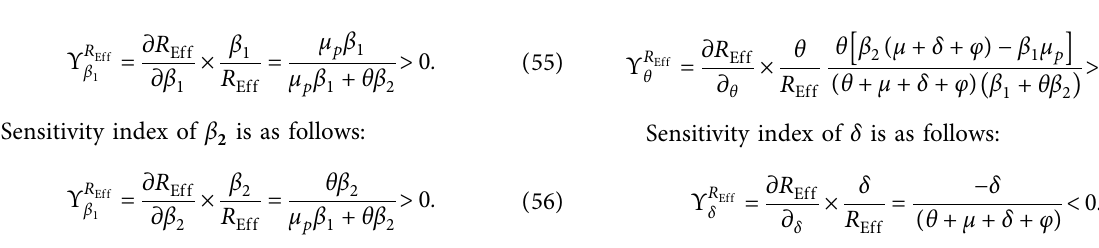
Figure 5: Efect of varying φ on human